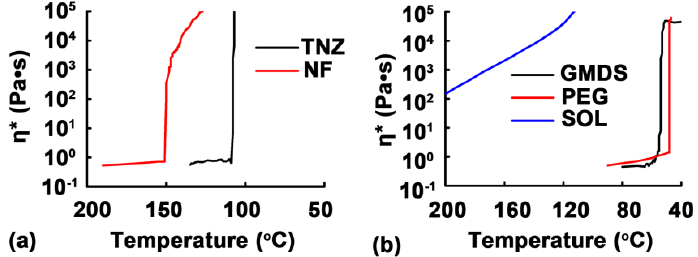
Figure 3. Morphology of the products composed of polyethylene glycol (PEG), mannitol, sucrose, Soluplus ® (SOL), stearic acid (SA), glycerol monostearate/distearate (GMDS), paraffin, and Eudragit ® RL PO (RL) prepared via MCA.